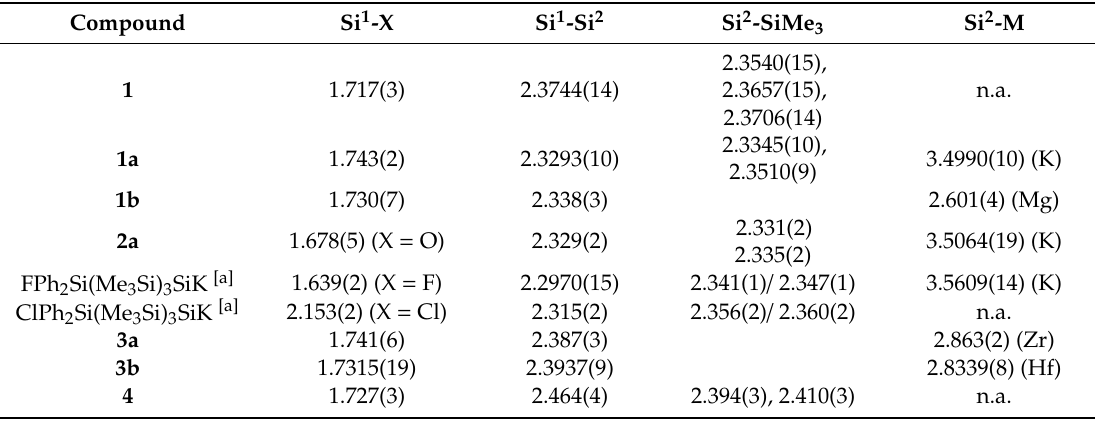
Table 1. Structural data of starting material 1, metallated compounds 1a , 1b , 2a , 3a , and 3b , coupling